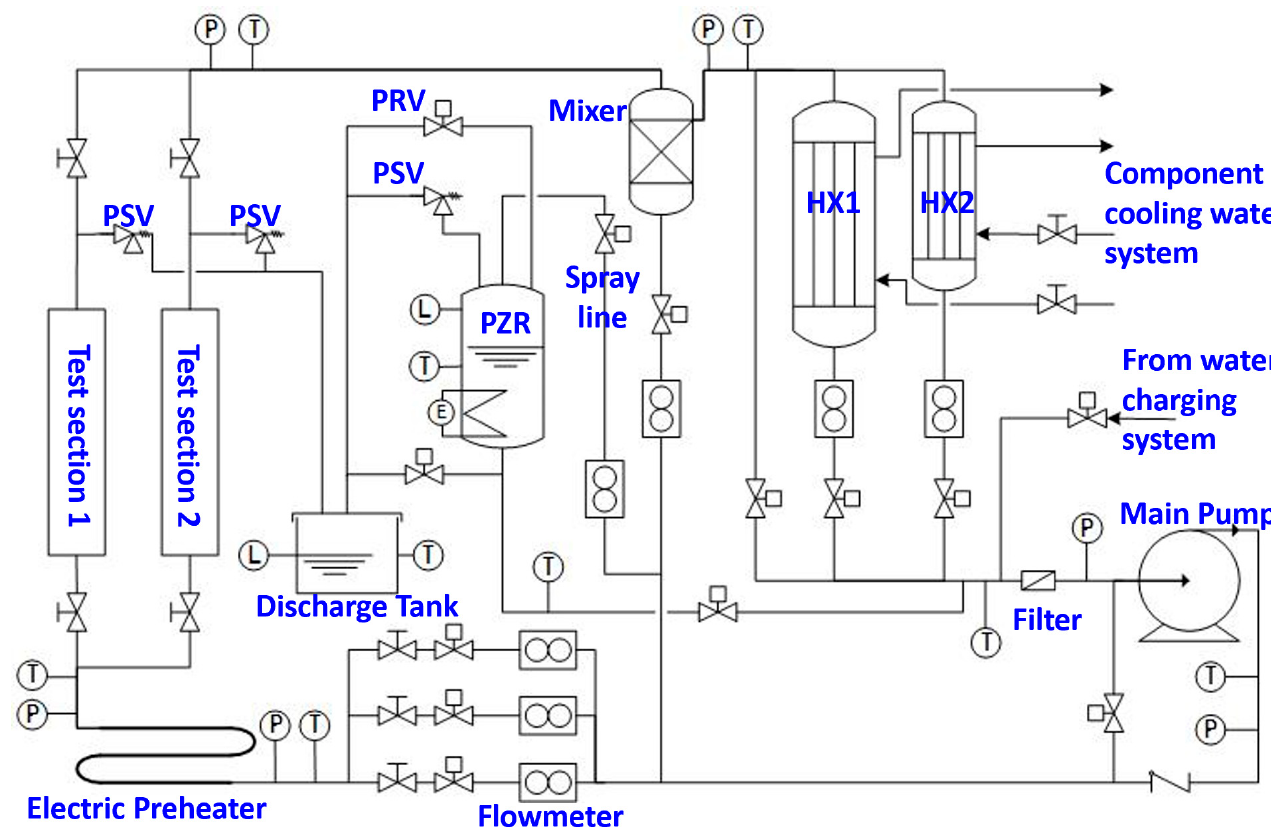
Figure 6. Scheme of the high pressure water loop.